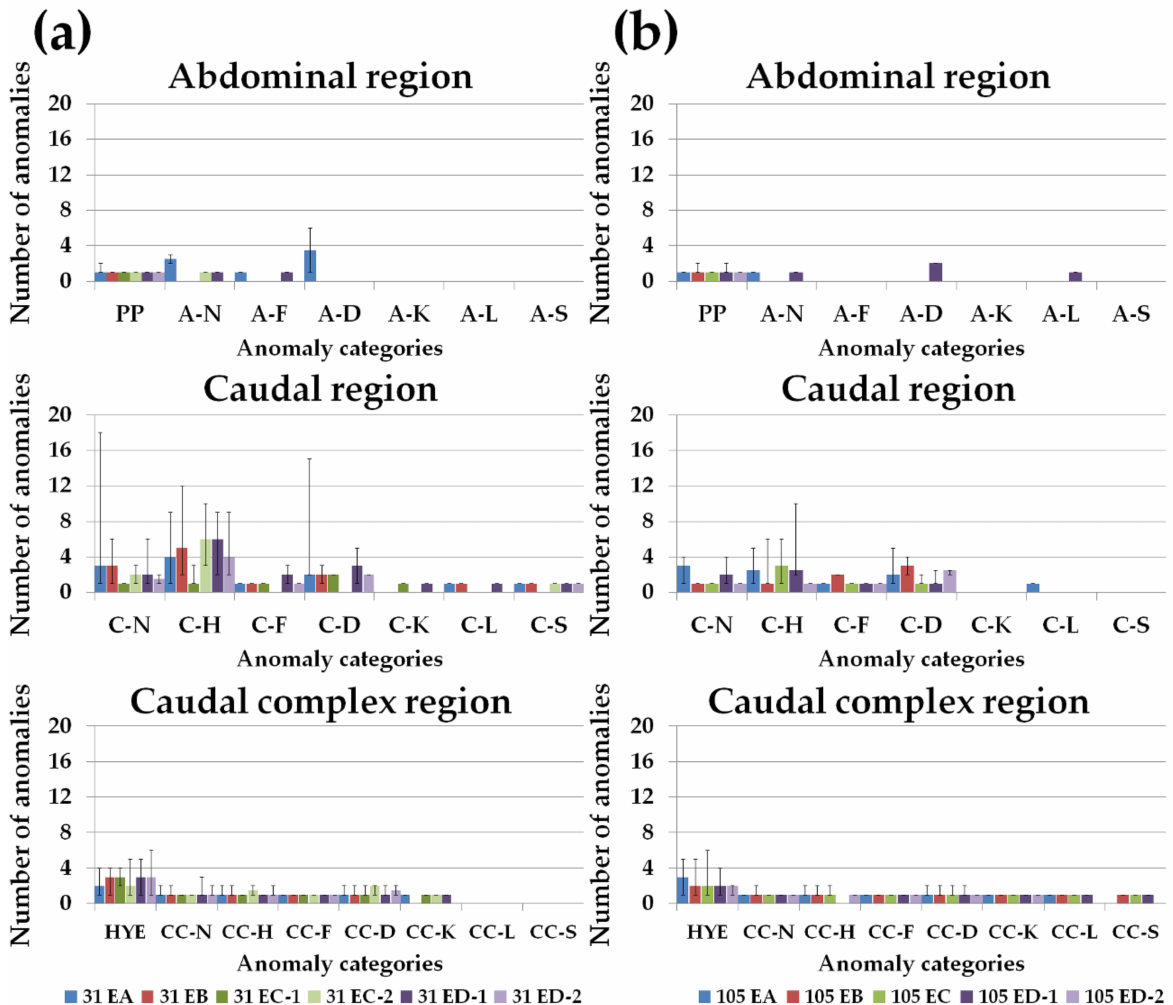
Figure 5. Anomaly index (number of anomalies per malformed specimen) in each group (31 EA, 31 EB, 31 EC-1, 31 EC-2, 31 ED-1, 31 ED-2, 105 EA, 105 EB, 105 EC, 105 ED-1, 105 ED-2). Graphs display median values, maximums, and minimums ( a ) 31 days after hatching (dah). ( b ) 105 dah. A-D: abdominal (A) deformation; A-F: A fusion; A-K: A kyphosis; A-L: A lordosis; A-N: A neural elements; A-S: A scoliosis; CC-D: caudal complex (CC) deformation; CC-F: CC fusion; CC-H: CC haemal elements; CC-K: CC kyphosis; CC-L: CC lordosis; CC-N: CC neural elements; CC-S: CC scoliosis; C-D: caudal (C) deformation; C-F: C fusion; C-H: C haemal elements; C-K: C kyphosis; C-L: C lordosis; C-N: C neural elements; C-S: C scoliosis; HYE: hypurals, epural, parhypural; PP: